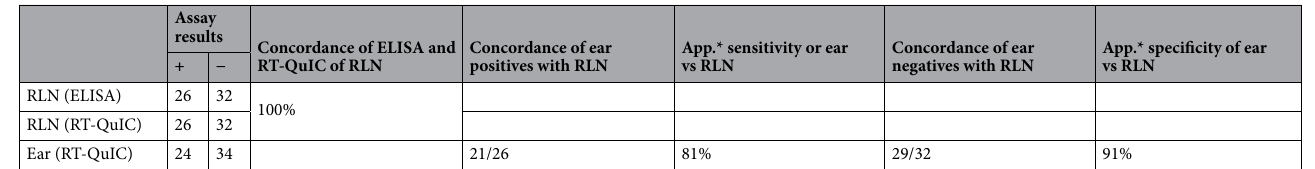
Table 2. Summary of RLN ELISA, RLN RT-QuIC and ear (area 7) IOME-RT-QuIC results from 58 deer (53 mule and 5 white-tailed). *Apparent; we use this adjective to indicate that these sensitivity and specificity values are based on analysis of RLN tissues, which might not be a completely accurate indication of the overall CWD infection status of the